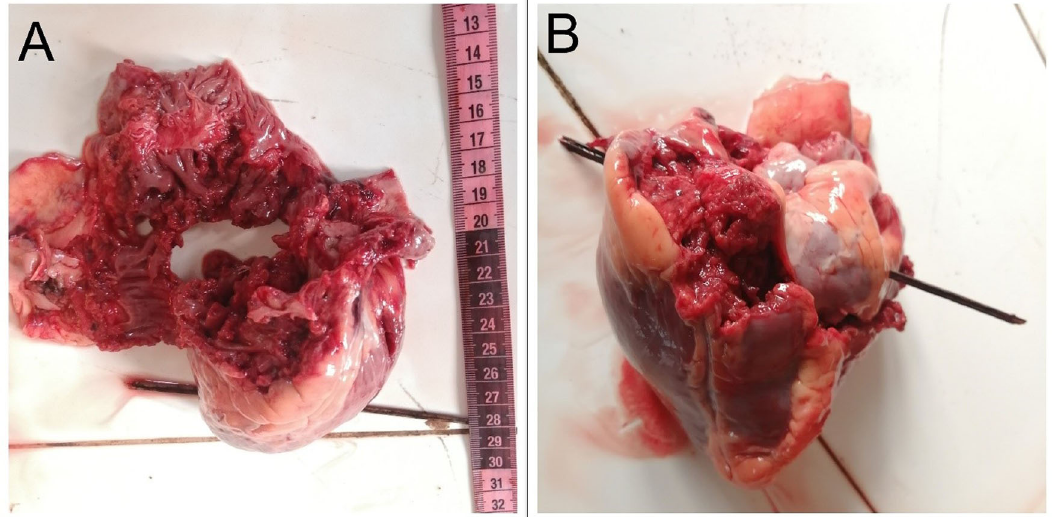
Figure 3. A, Pulverized heart. B, A wooden probe passed through the defect showing the direction of the projectile.